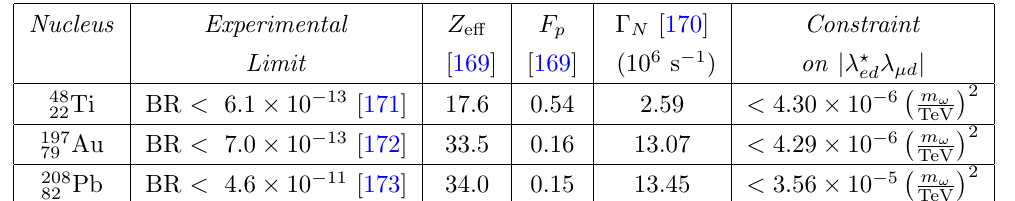
Table 12 . Constraints on Yukawa couplings and LQ masses from (cid:22) nuclei. For (cid:21) 0 ? (cid:21) 0 , the same constraints apply, with m ! replaced by m (cid:31) ed (cid:22)d j j